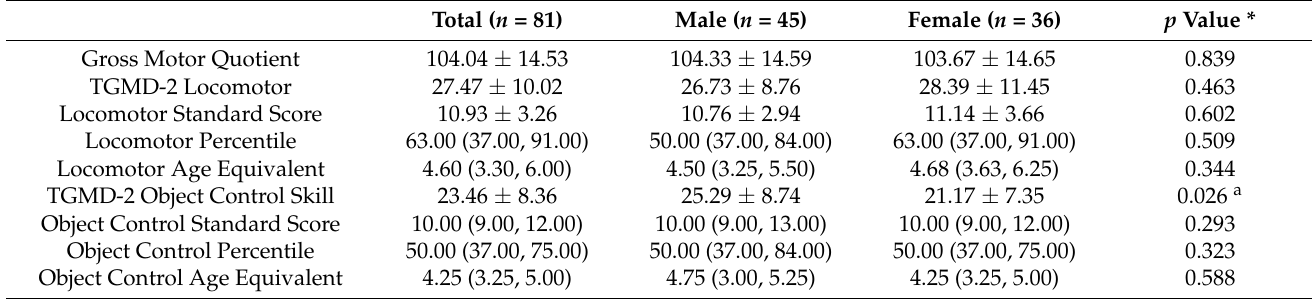
Table 2. Test for Gross Motor Development-2 data.